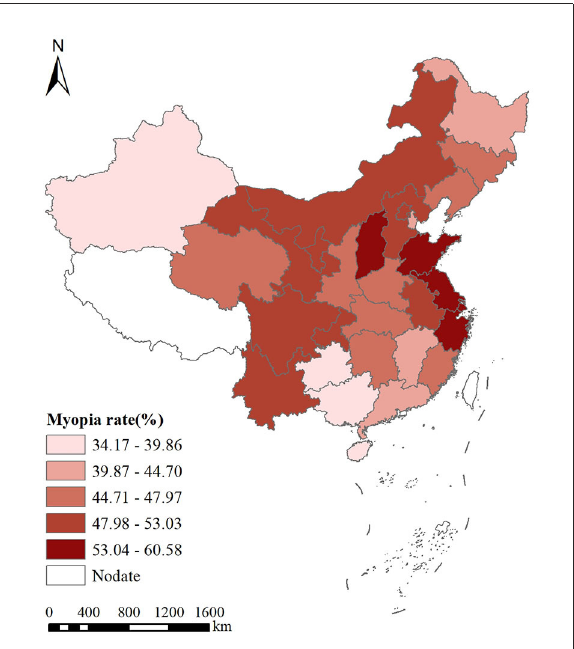
FIGURE1 Spatial distribution of the prevalence of myopia in China from 1995 to